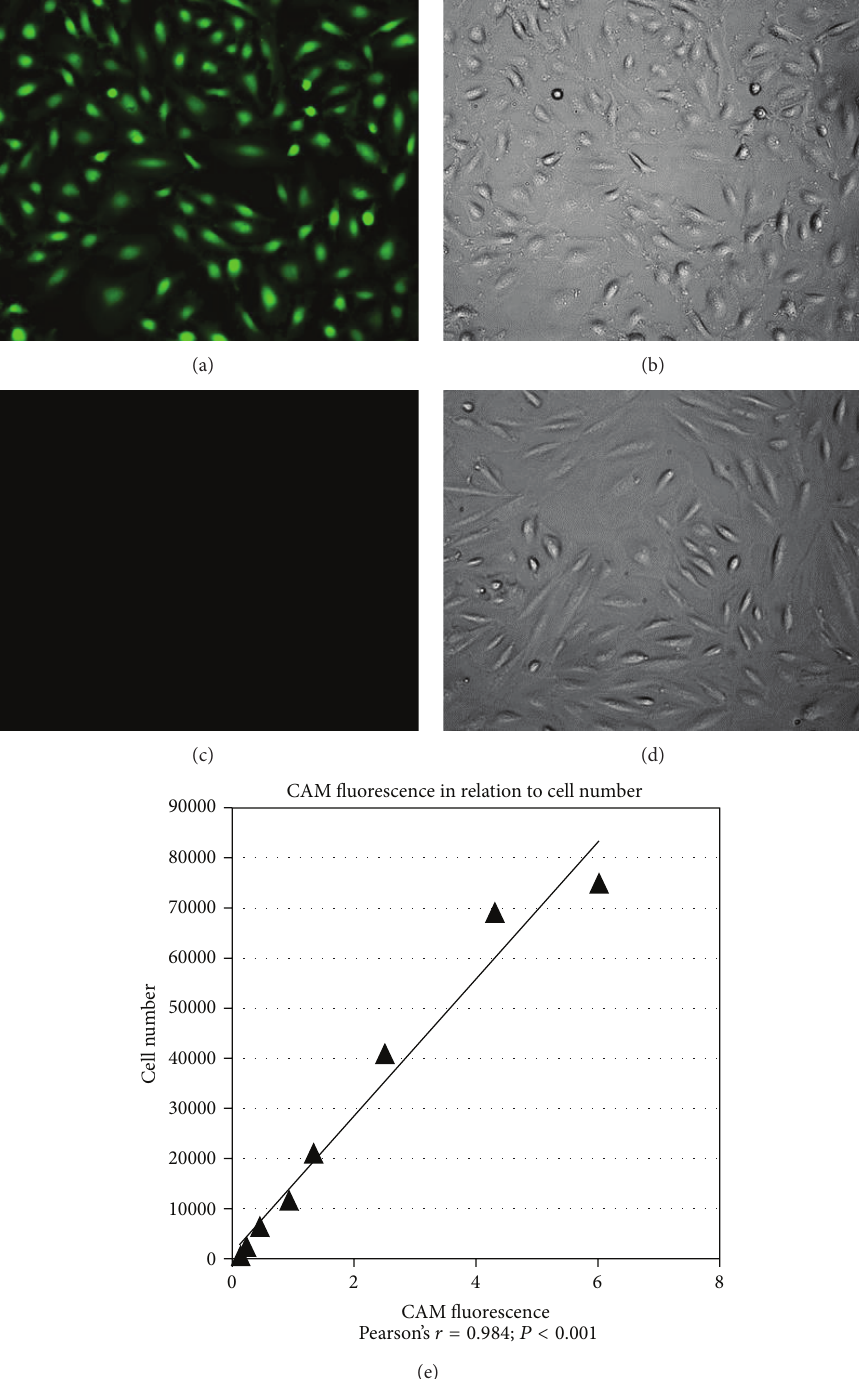
Figure 2: A calcein-acetoxymethyl ester (CAM) reagent, which exclusively stains living cells, was used to analyze cell survival. To validate the method, control cells and methanol-fixed cells were incubated with PBS containing 1 𝜇 M CAM (green). (a) Control cells were CAM+ (green). (b) Corresponding phase contrast micrograph to (a). (c) Fixed cells were CAM − . (d) Corresponding phase contrast micrograph to (c). (e) Cells were seeded in multidishes in increasing concentrations and incubated for two hours to ensure attachment to the substrate. The CAM reagent was added to the cells for one hour, and the CAM fluorescence was measured with a microplate fluorometer. The number of seeded cells correlated significantly with the measured CAM fluorescence, thereby proving great accuracy of the microplate reader